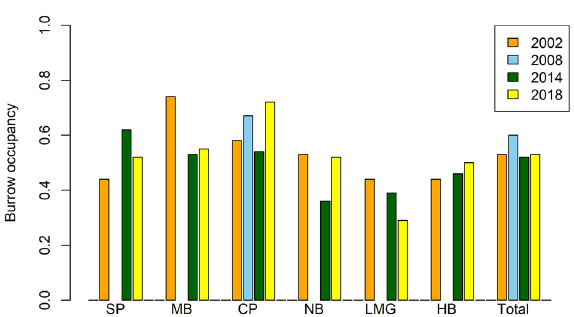
Figure 4. Burrow occupancy for each colony during each year. (SP, Stevens Point; MB, Middle Beach; CP, Clear Place; NB, Neds Beach; LMBG, Little Muttonbird Ground; HB, Hunter Bay).